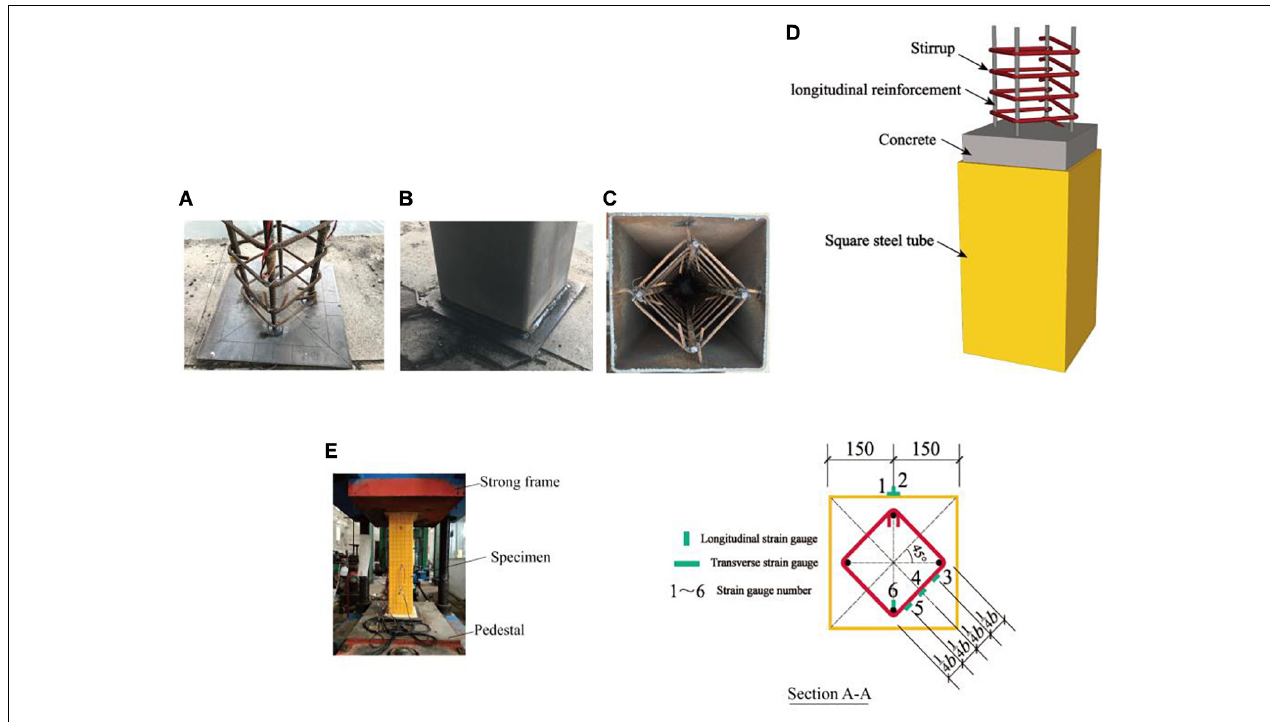
FIGURE 2 | Specimen fabrication and test measuring facilities. (A) Welded stirrup cage. (B) Welded steel tube. (C) Section of specimen. (D) 3D diagram. (E) Test setup and arrangement of strain